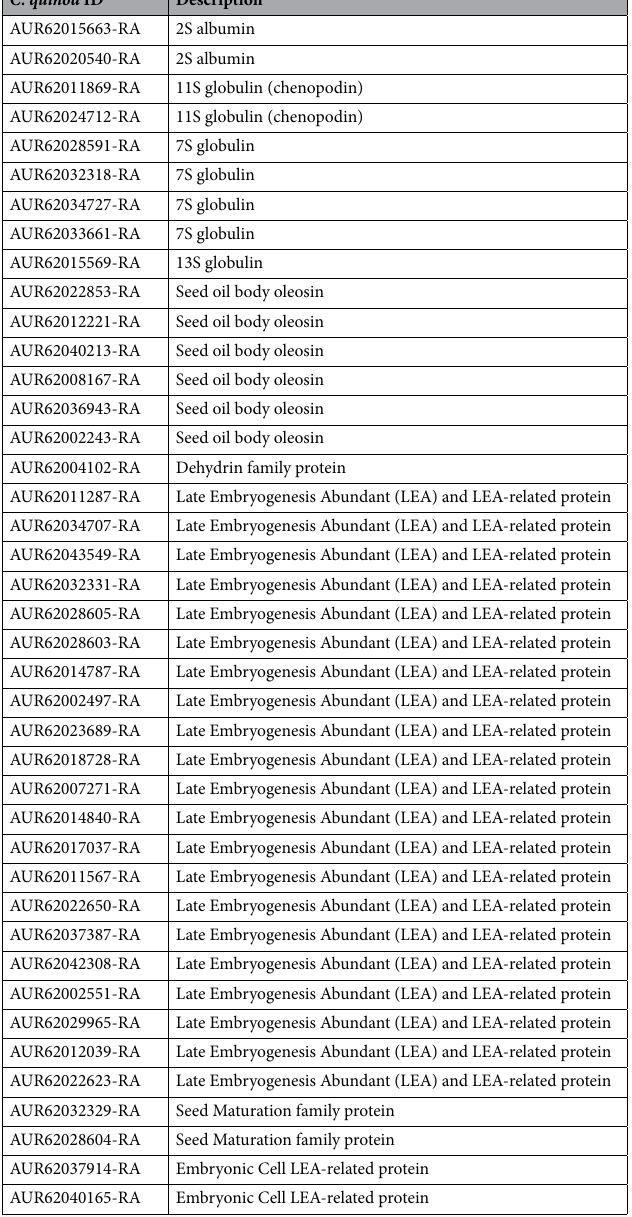
Table 1. SSPs and other characteristic seed-related proteins simultaneously found in seeds harvested from irrigated and rainfed